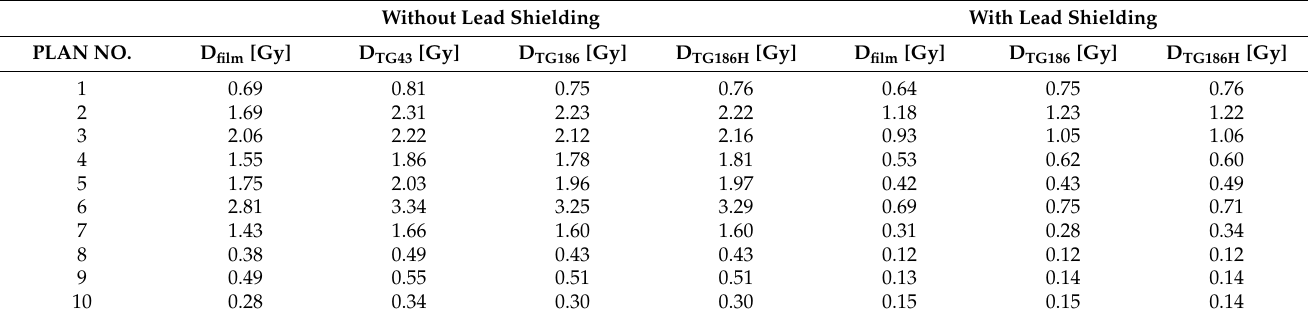
Table 7. Dose values measured and calculated at a point in the lens of the eye. Without Lead Shielding With Lead Shielding